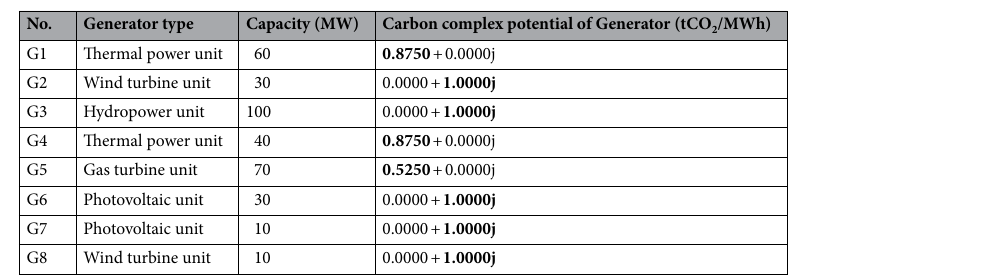
Table 6 lists the generator parameters of the 30–node test system. Let (cid:31) = 0.3 ; the network loss is shared by the power generation side and the user side. When (cid:31) = 0.3 , that is, when 30% of the network loss is allocated to the user side and 70% is allocated to the generation side, the load carbon flow rate and the unit injection carbon flow rate of the 30-bus test system can be obtained using Eqs. (4) and (5), as shown in Table 7. Various expressions can be derived from the load carbon flow rate and the unit injection carbon flow rate presented in Table 7 by applying the complex structure carbon intensity. For instance, the load real carbon flow rate at Node 8 was as high as 31.2421, and the load real carbon flow rate at Node 18 was only 0.7239. The real load carbon flow rate at Nodes 4 and 5 did not vary significantly; however, the virtual load carbon flow rate at Nodes 4 and 5 varied significantly. In other words, the new energy consumption of Node 5 is much higher than that of Node 4. Table 8 presents the node carbon intensity for the 30–node test system. Combined with the analysis of Eq. (1), the node carbon intensity is only affected by the injection power flow, whereas Node 3 is only injected by Node 1. However, the carbon intensity of Node 3 is not equal to that of Node 1 because the network loss of Branch 1 → 2 is considered. According to Table 8, Nodes 1, 3, 9, and 10 represent the real carbon intensity, Node 13 represents the imagi- nary carbon intensity, while the other nodes represent complex structure carbon intensity. From the 30-node topology presented in Fig. 2, Nodes 1, 3, 9, and 10 are only injected using thermal power units, Node 13 is only injected using the new G6 energy units, and the other nodes are the mixed power supply. The load at Nodes 3 and 29 is 2.4 MW. However, the carbon emissions shared vary owing to the two nodes’ different carbon intensities. Users can proceed with site selection from a carbon perspective. Conversely, the users at Node 3 can reduce the shared carbon emissions by building new energy units or actively purchasing new energy sources.